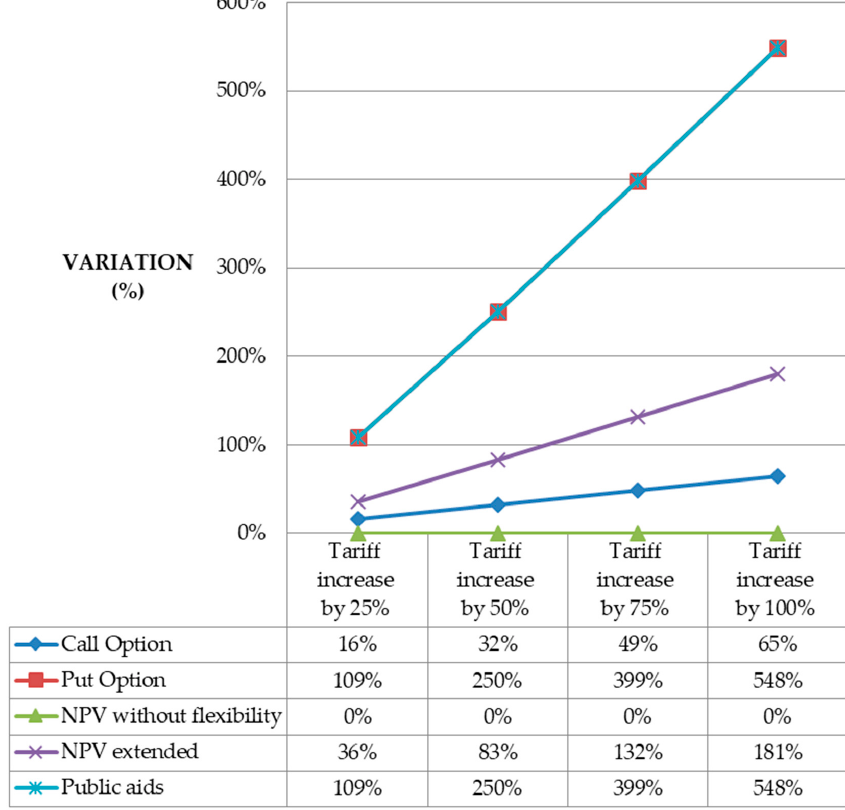
Figure 4. Percentage variation in base scenario (source: own elaboration).